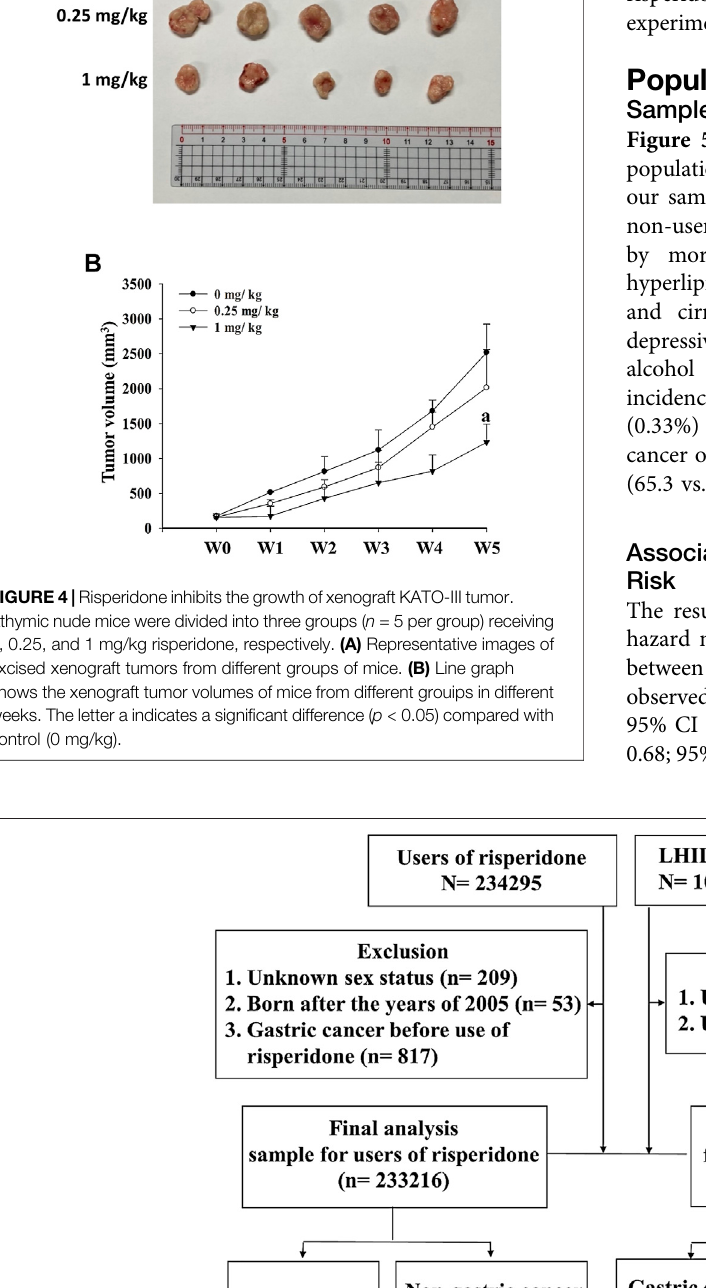
Frontiers in Pharmacology |